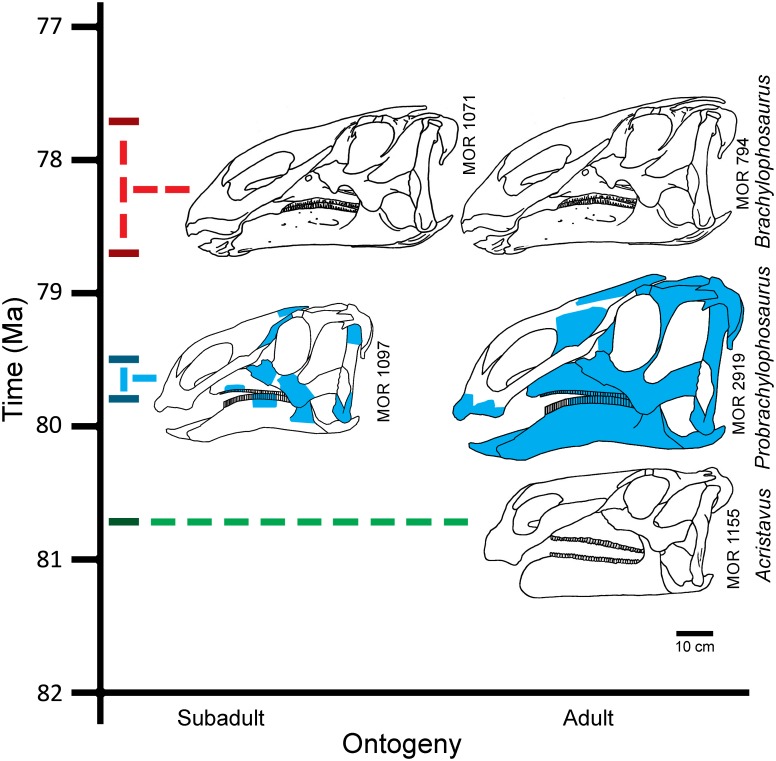
Ontogenetic and anagenetic hypothesis of brachylophosaurin evolution.
Probrachylophosaurus bergei gen. et sp. nov. is proposed as an intermediate member of the lineage leading from Acristavus gagslarsoni to Brachylophosaurus canadensis. Shaded blue areas indicate known elements of Probrachylophosaurus. Skull outlines of Acristavus and Brachylophosaurus are used courtesy of Terry A. Gates. The reconstruction of the MOR 1071 Brachylophosaurus skull is a composite of an articulated skull roof with a scaled-down copy of the MOR 794 skull outline. All skulls are scaled to the same 10 cm scale bar. The horizontal axis is not to scale; the MOR 1071 reconstruction is much closer to MOR 794 in size and hypothesized maturity than MOR 1097 is to MOR 2919. Radiometric ages have been recalibrated to the Fish Canyon sanidine standard (28.305 +/- 0.036 Ma) of Renne et al. [10] from the originally published values [3, 11–13]; see text and Table 1 for further recalibration details. The age of the Acristavus holotype was precisely estimated by Gates et al. [3]. The age of the Comrey Sandstone Zone of the Oldman Formation is not tightly constrained, leading to uncertainty in the exact age of Brachylophosaurus.